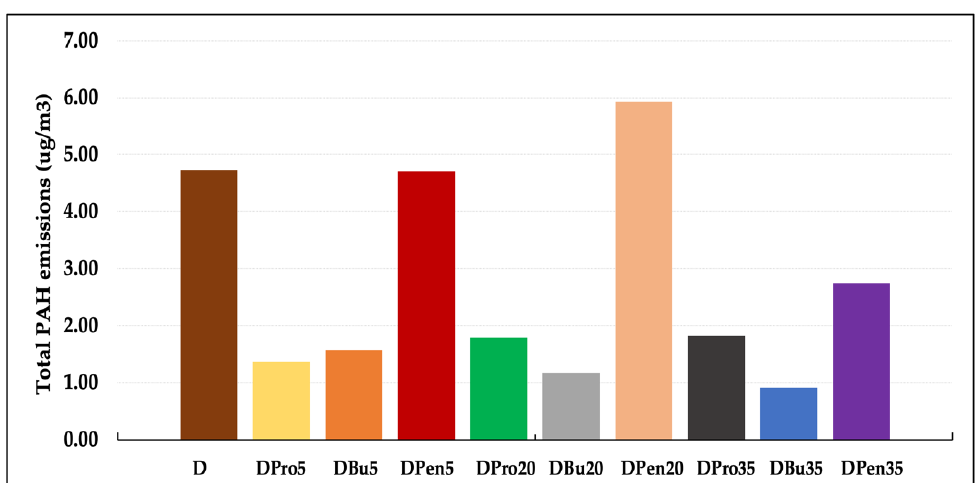
Figure 5. Total PAH emissions of test fuels .